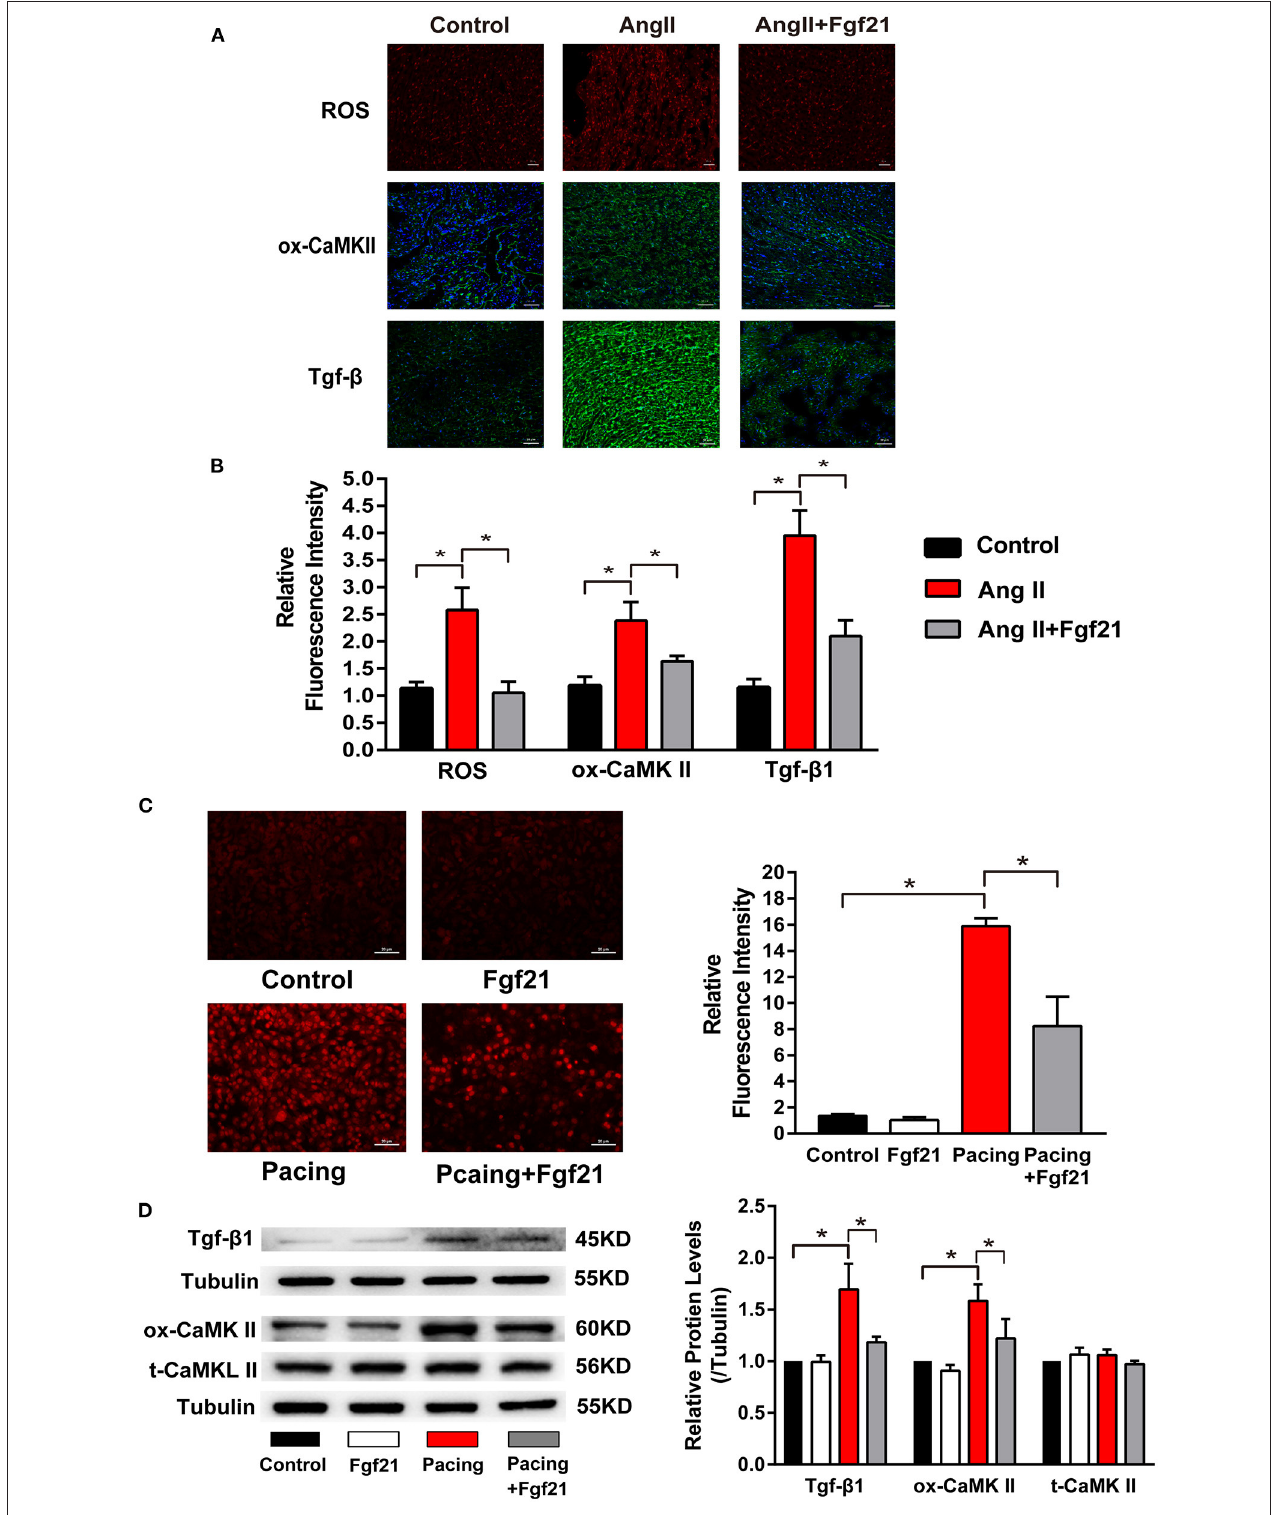
FIGURE 5 | The effects of Fgf21 on oxidative stress in the atria. (A) Representative photomicrographs of the atria slices from each group mouse stained with immunohistochemistry of reactive oxygen species (ROS), ox-CaMKII, and Tgf- β . Scale bar indicates 50 µ m. (B) Summary of the relative fluorescence intensity of ROS, ox-CaMKII, and Tgf- β in the atria of each group mouse. (C) Representative images of ROS detected by dihydroethidium (DHE) and a summary of the relative fluorescence intensity of ROS in each group of HL-1 atrial cells. (D) The expression of Tgf- β , ox-CaMKII, and t-CaMKII at protein levels in each group of HL-1 atrial cells. * p <